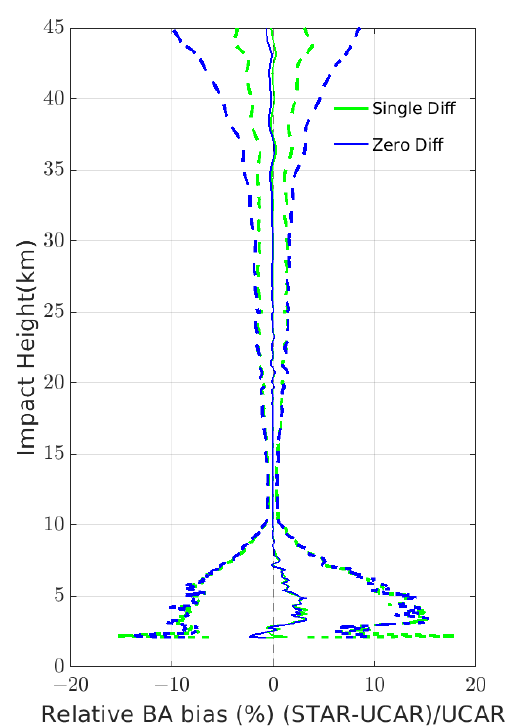
Figure 11. Bending angle comparison with UCAR for 2019.275, for all non-L2P observation profiles, the outer envelope indicates one standard deviation; the middle two lines indicate relative differences. The green color represents the results of a single differencing, and the blue color for zero differencing.